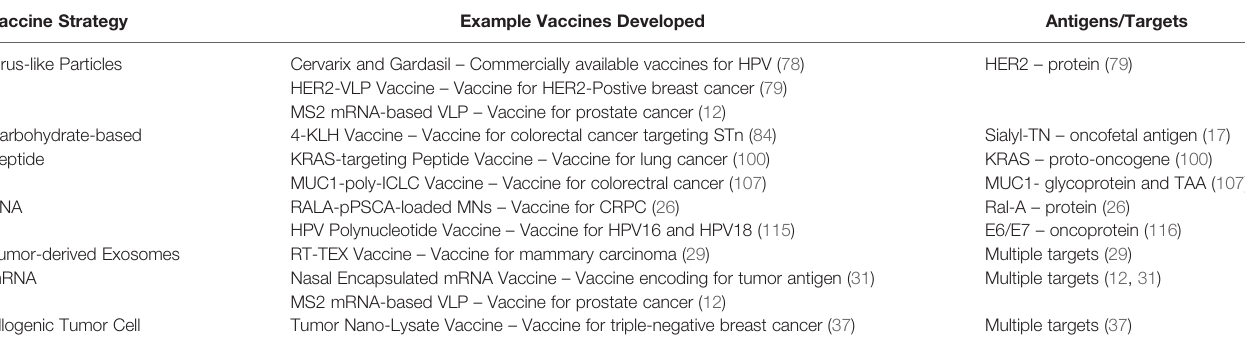
TABLE 2 | Summary of the most promising prophylactic cancer vaccine formulations and possible antigens and targets associated with each vaccine strategy. Vaccine